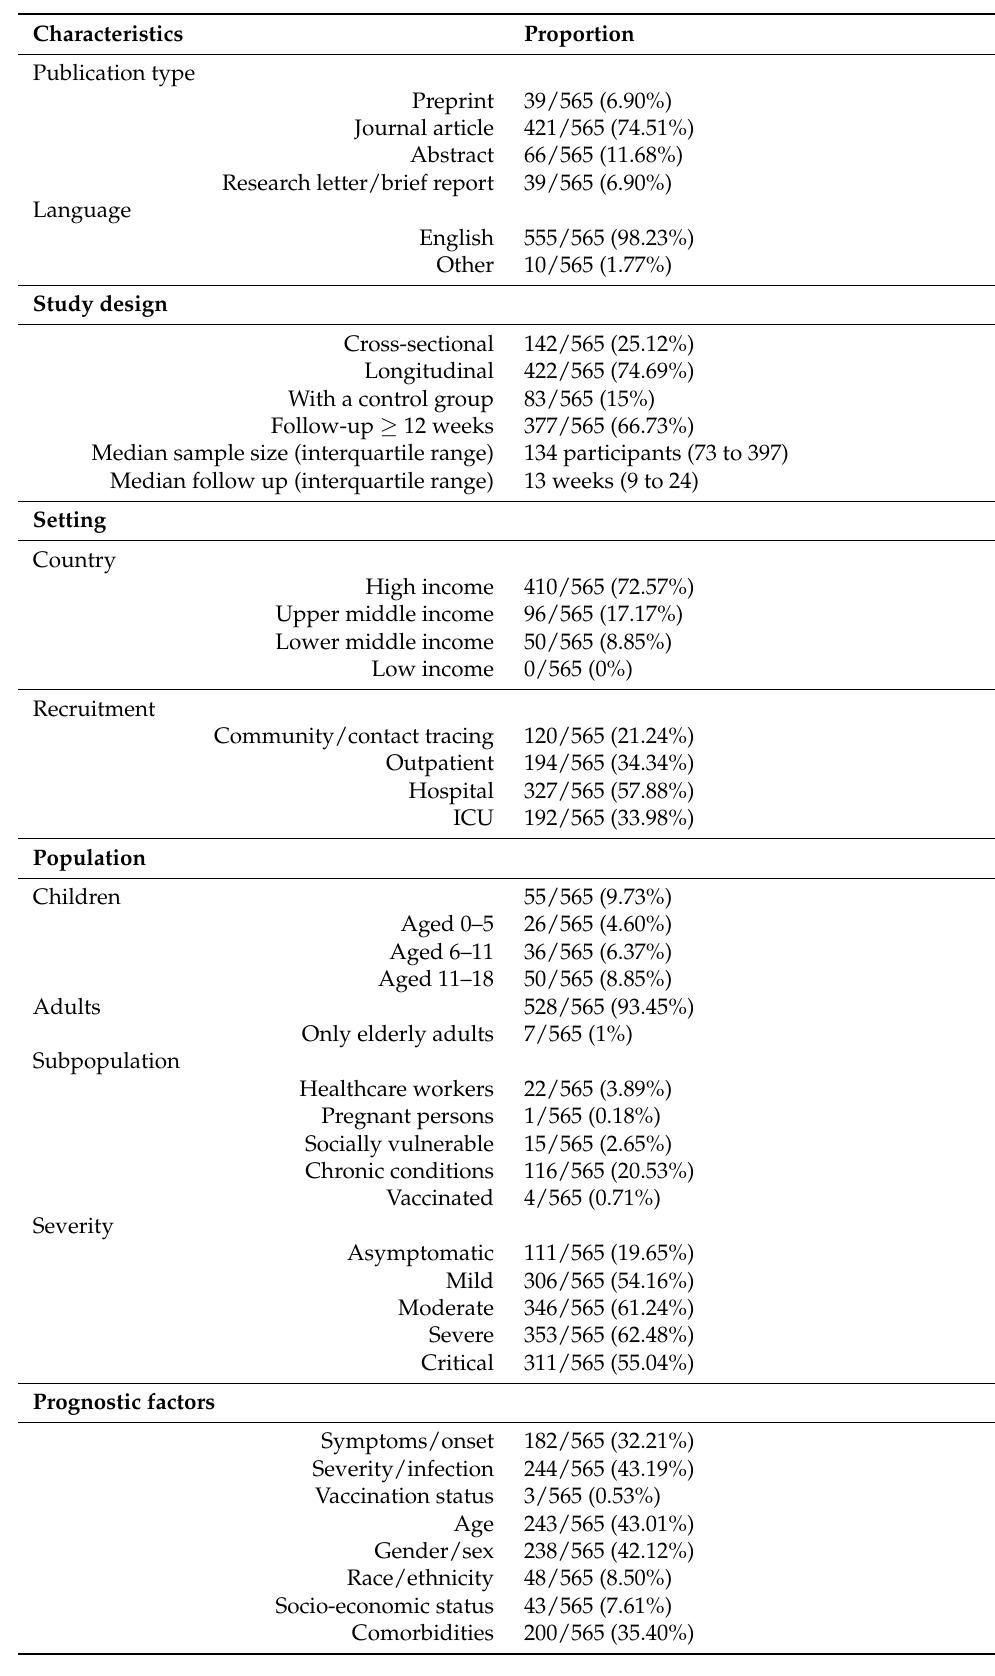
Table 2. Characteristics of included